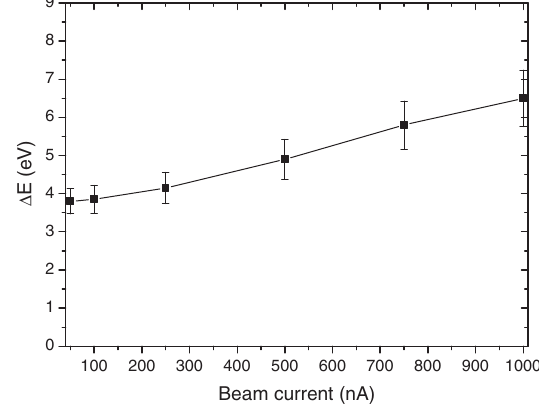
FIG. 12. Space charge effect on the longitudinal energy spread: variation of the longitudinal energy spread with the beam current.